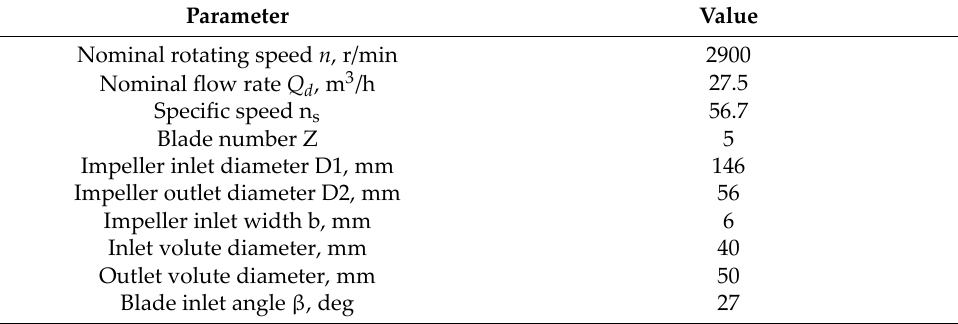
Table 4. Main geometric parameters of the Multi‑stage